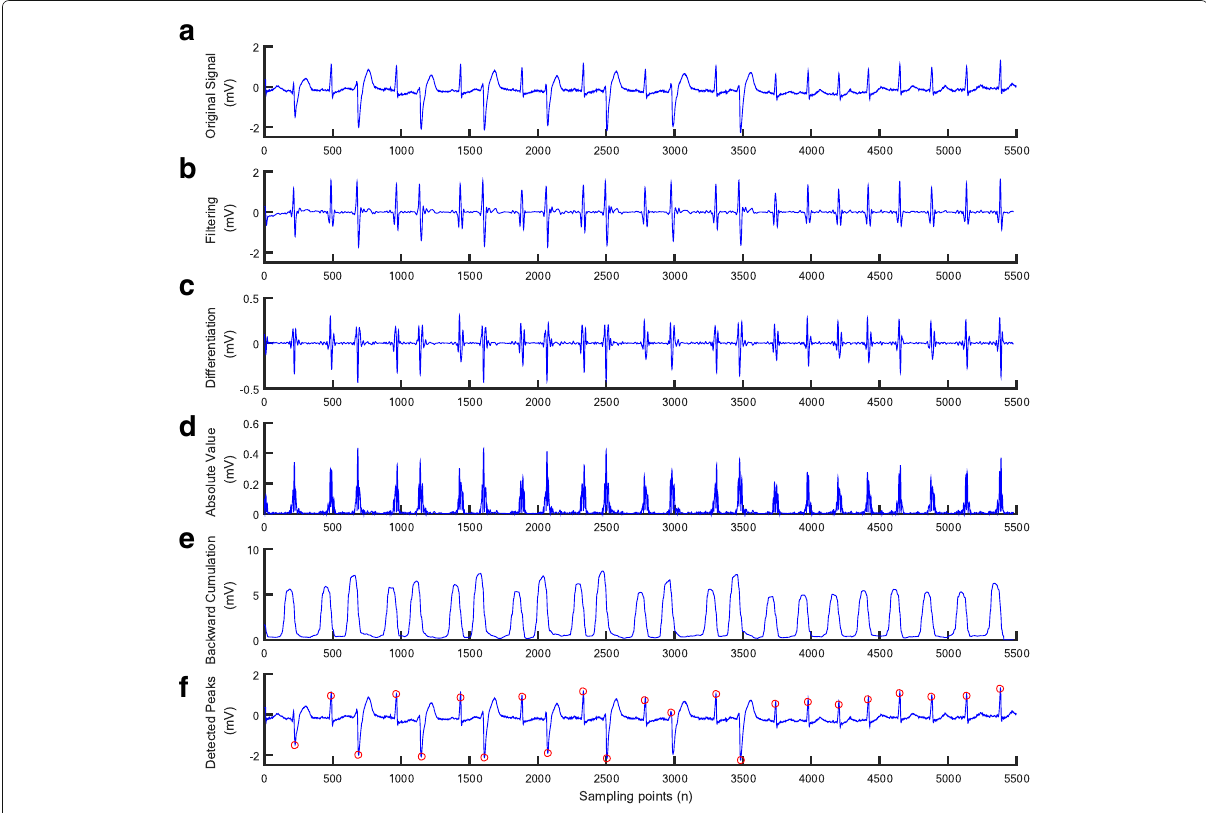
Fig. 4 Result after performing each stage of the proposed method for the ECG with high frequency noise and artifact (ECG recording 200). a ) Original signal. b ) Filtering. c ) Differentiation. d ) Absolute value. e ) Backward cumulation. f ) Detected peaks